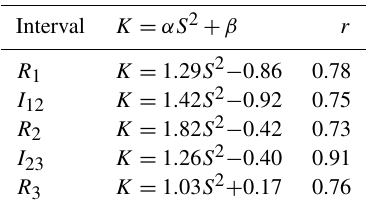
Figure 3. Kurtosis K as a function of skewness S computed using overlapping windows of size 10000 data points and a window shift of 400 data points, for (a) the interior region of IMFR-1, (b) the interface of IMFR-1 and IMFR-2, (c) the interior of IMFR-2, (d) the interface of IMFR-2 and IMFR-3, and (e) the interior of IMFR-3. In each panel, the least-square fit with the parabolic function K = αS 2 + β is displayed as a dashed line (see Table 3). Table 3. The least-square fits of Eq. (7) computed from the scat- ter plots of Fig. 3, and the correlation index r for the five regions